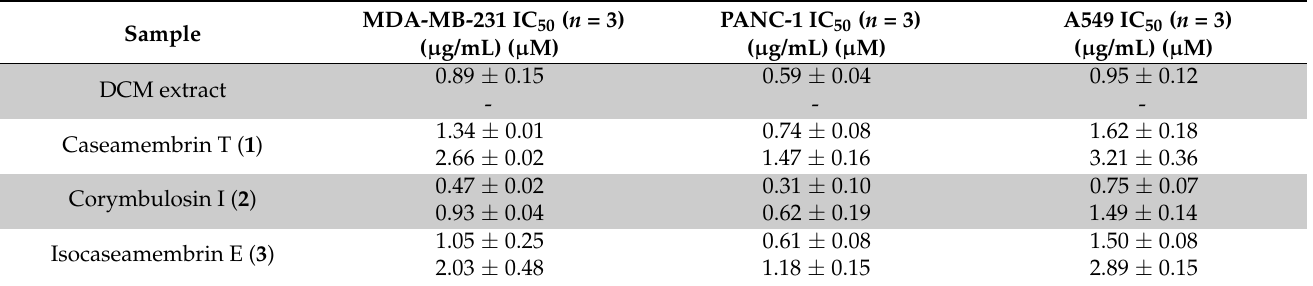
with the DNA, as Michael acceptors are well described as DNA-interacting molecules [32]. Table 3. IC 50 of compounds 1 – 3 and the crude extract on the investigated cell lines, expressed in µ g/mL ± SD and µ M ± SD. The activity against PANC-1 cells differs from the other two cell lines, and the activity of compounds 1 and 3 are also closer to those of the extract and compound 2